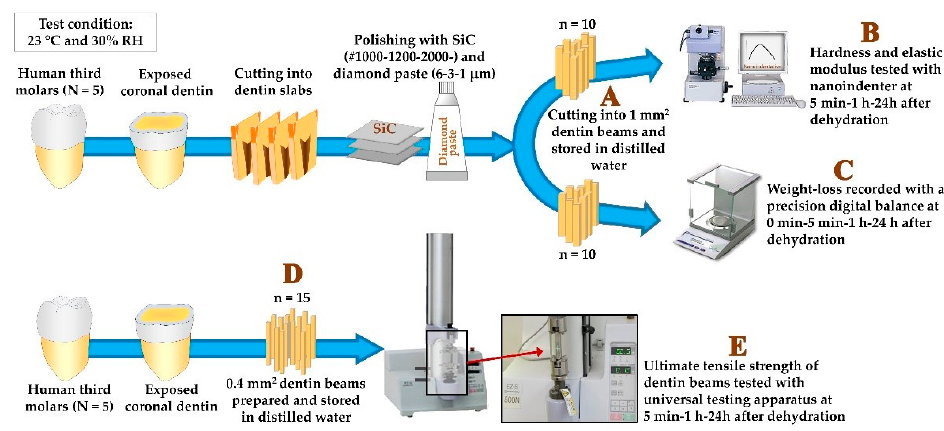
Figure 1. Schematic overview of the study.